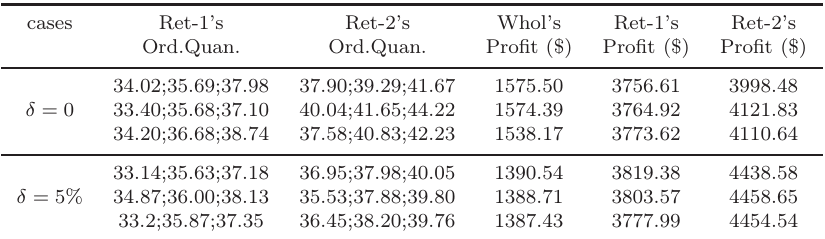
Table 1. Optimum order quantities and profits obtained by Proc 2 via